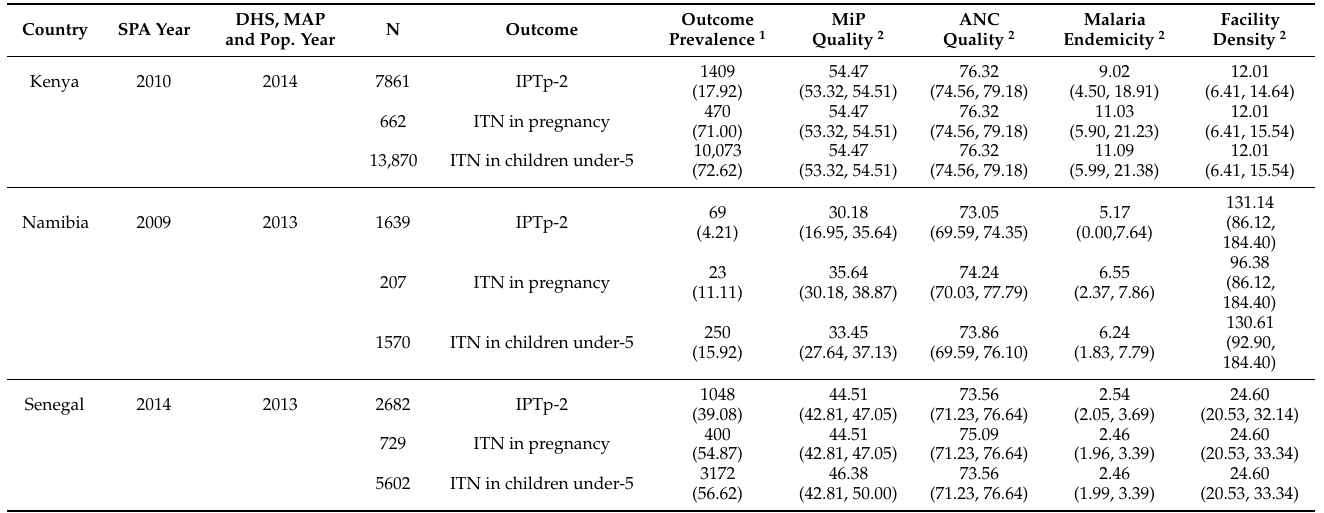
Table 2. Selected unweighted characteristics of country and pooled data by study